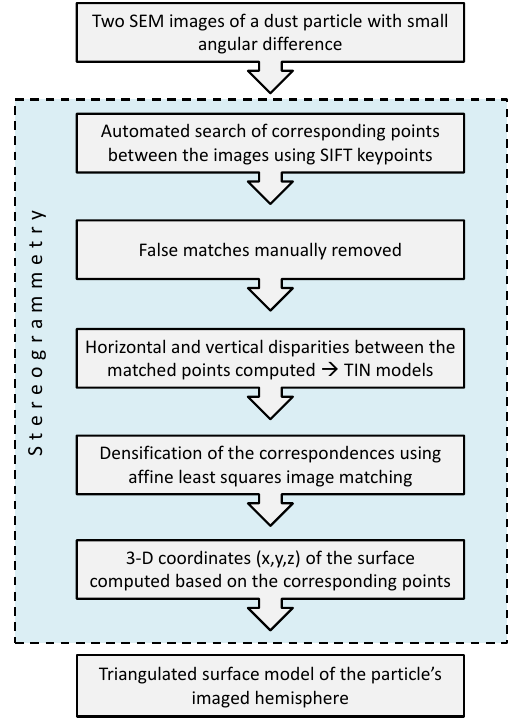
Fig. 3. A schematic presentation of the stereogrammetric shape re- trieval method. A detailed description of each of the phases is given in Sect.